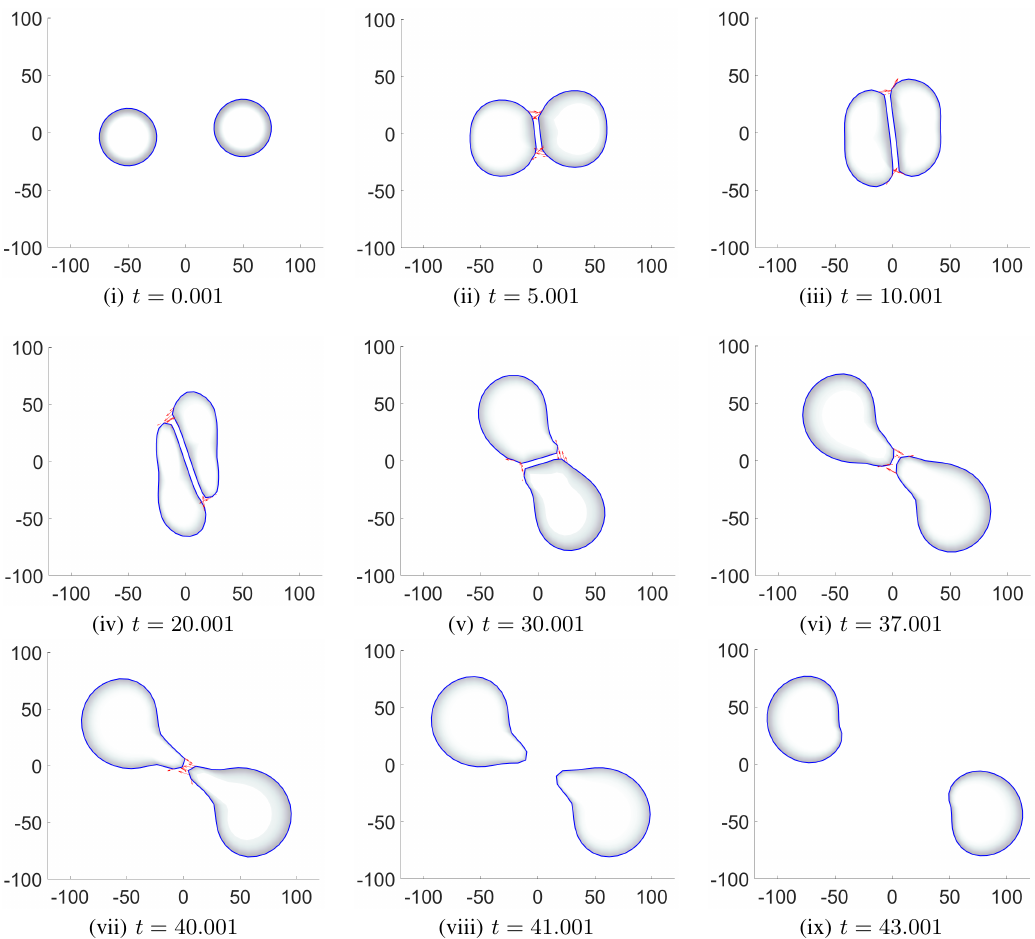
Experiment 2 (Cell-cell adhesion) As in Figure 4, two cells are found in opposing colliding paths. This time though, they are able to develop cadherin induced cell-cell-adhesions. This has an impact in the deformation of the cells, their migrations, and their tendency to stick with each other and to resist their separation. (ii)—(v): The adhesive forces are stronger at the ends of the colliding parts of their membranes than the middle parts of it. (vi)—(ix): Note the elastic retraction of the “tail”/rear part of the cell. (ix): Note also the larger time that is needed for the cells to reach the boundary of the domain, as opposed to the cell-cell collision experiment in Figure